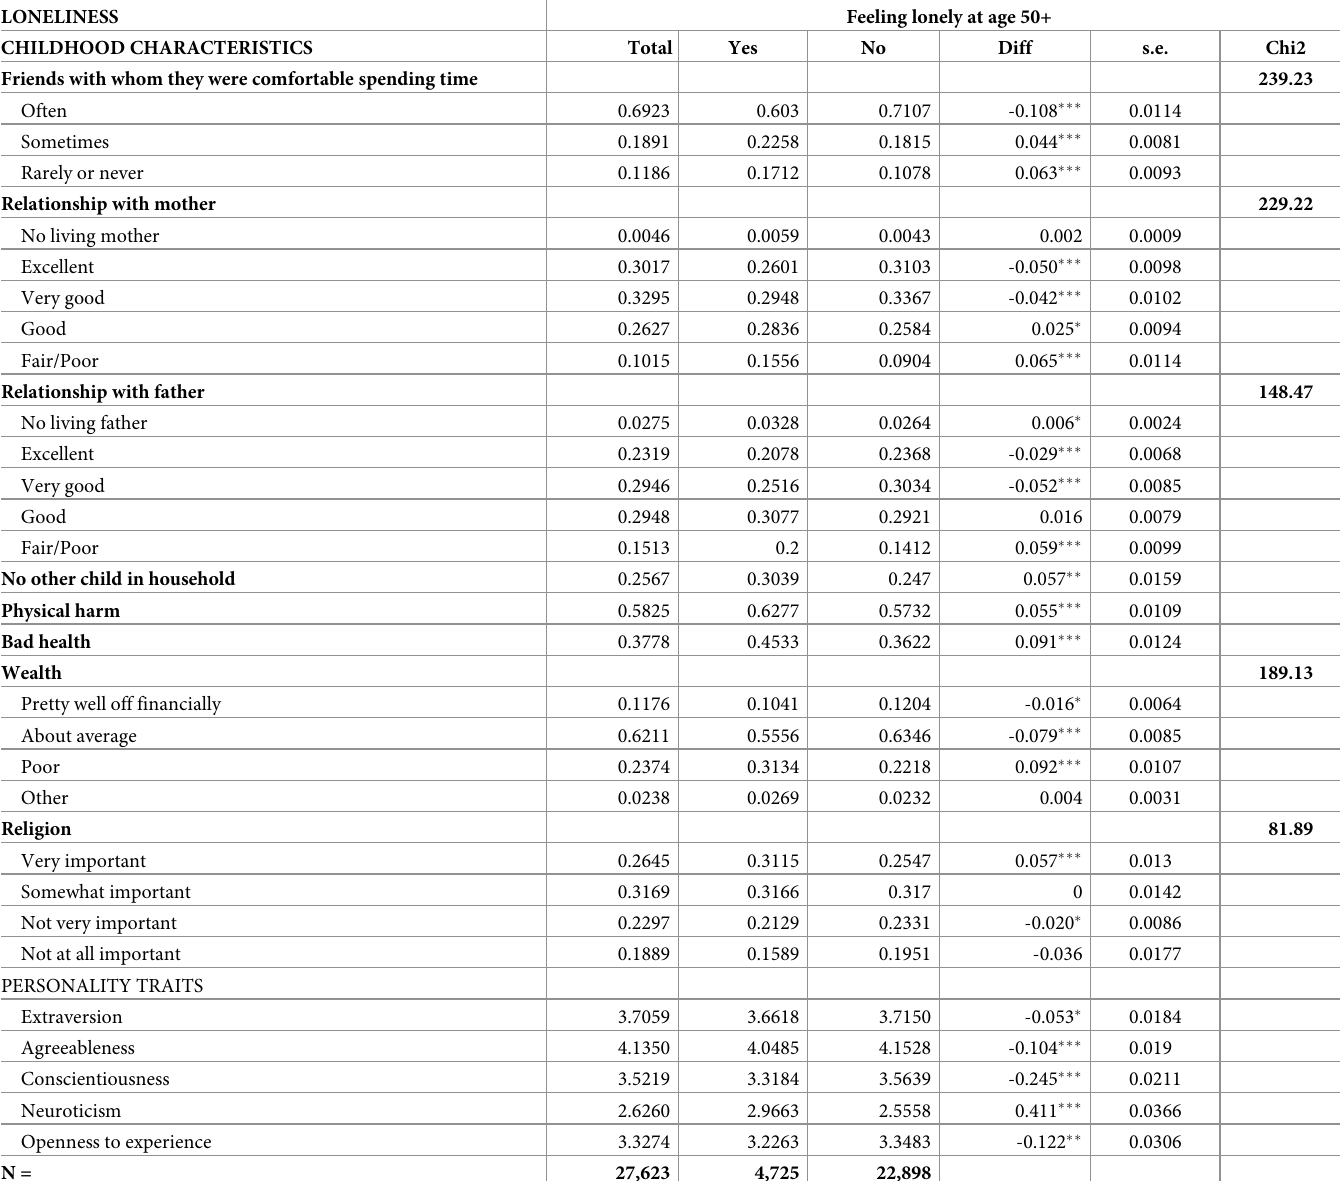
Table 1. Loneliness status at age 50+ by childhood circumstances and personality traits.